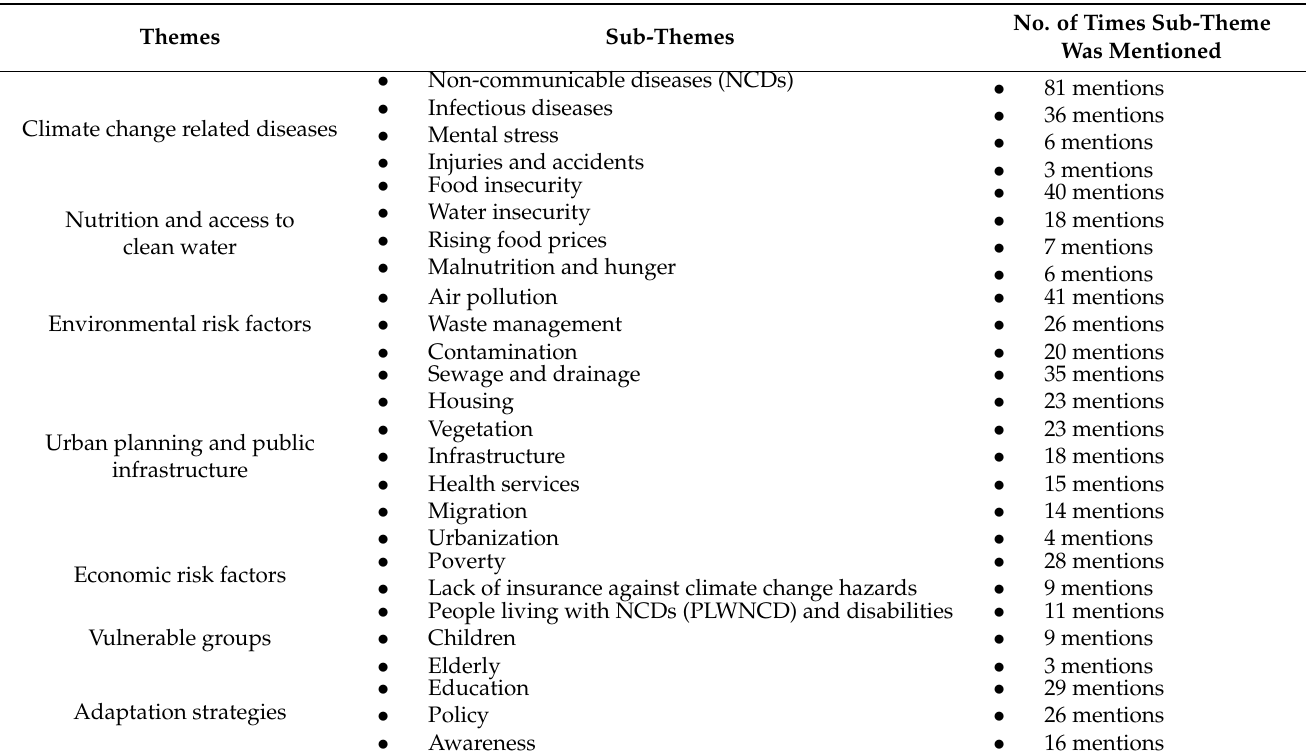
Table 1. Results based on themes and sub-themes.